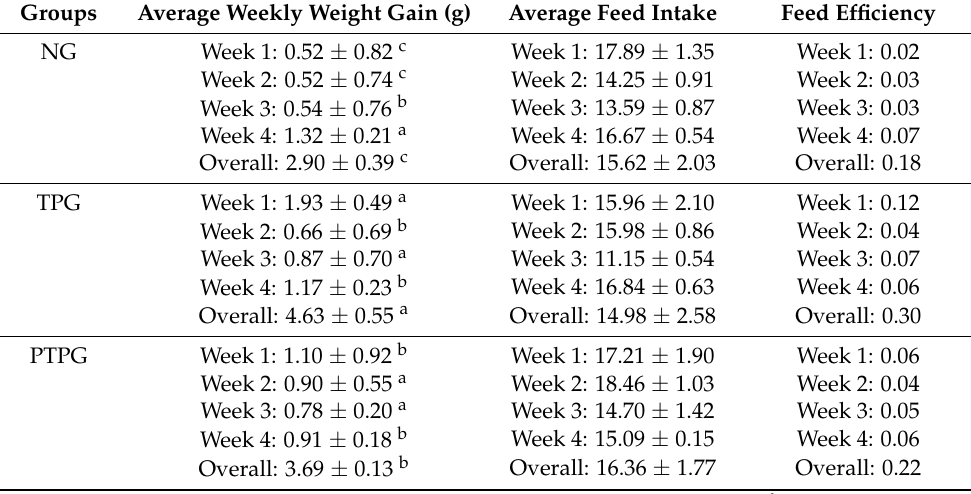
Table 6. Effects on the body weight, food intake, and feed efficiency.